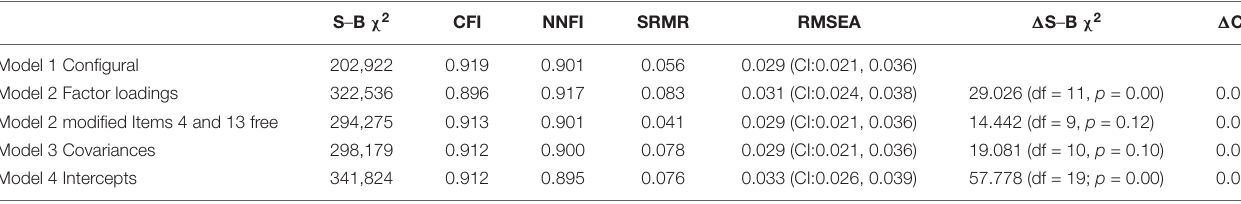
TABLE 5 | Measurement invariance of SRQ (two-factor model) for males ( n = 176) and females ( n =